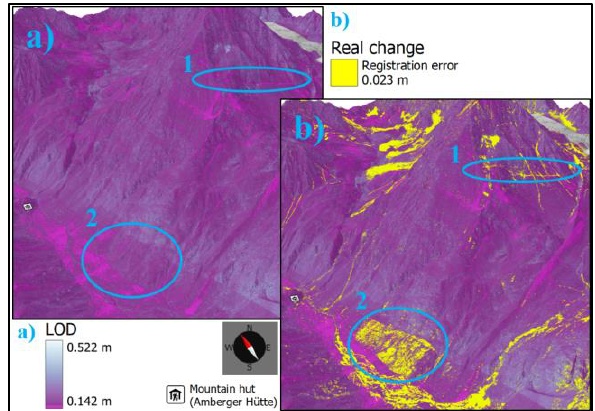
Figure 6 . LOD and thresholded real change , both calculated with an estimated registration error of 0.023 m.